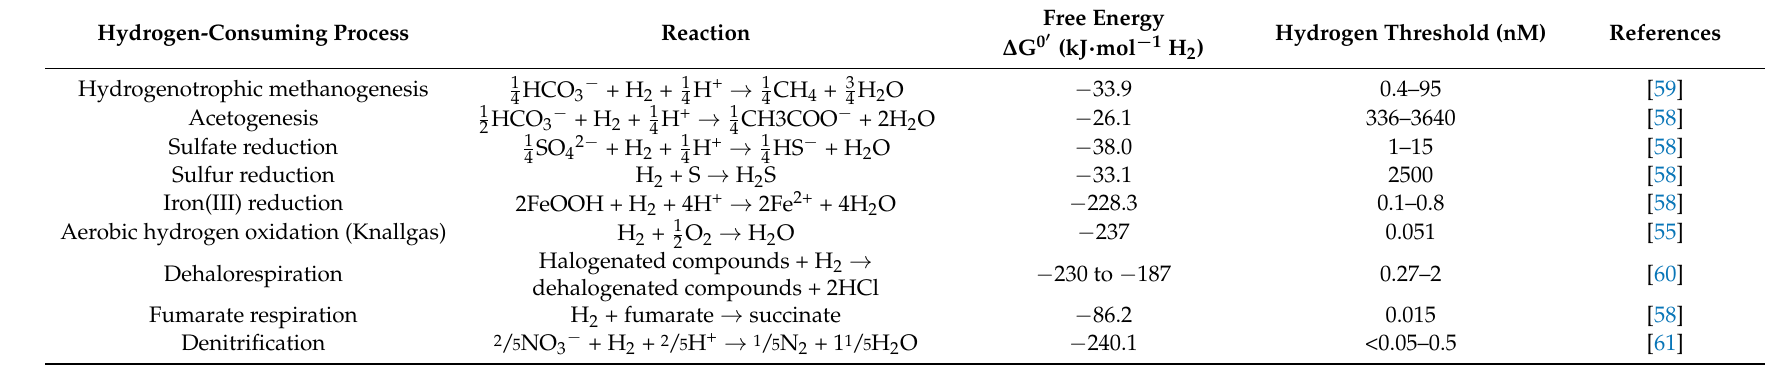
Table 3. Examples of microbial hydrogen-consuming reactions. Based on data in Reference [58]. Free energies not included in Reference [58] were calculated from Gibbs free energies of formation [42]. Hydrogen threshold values were expanded using provided